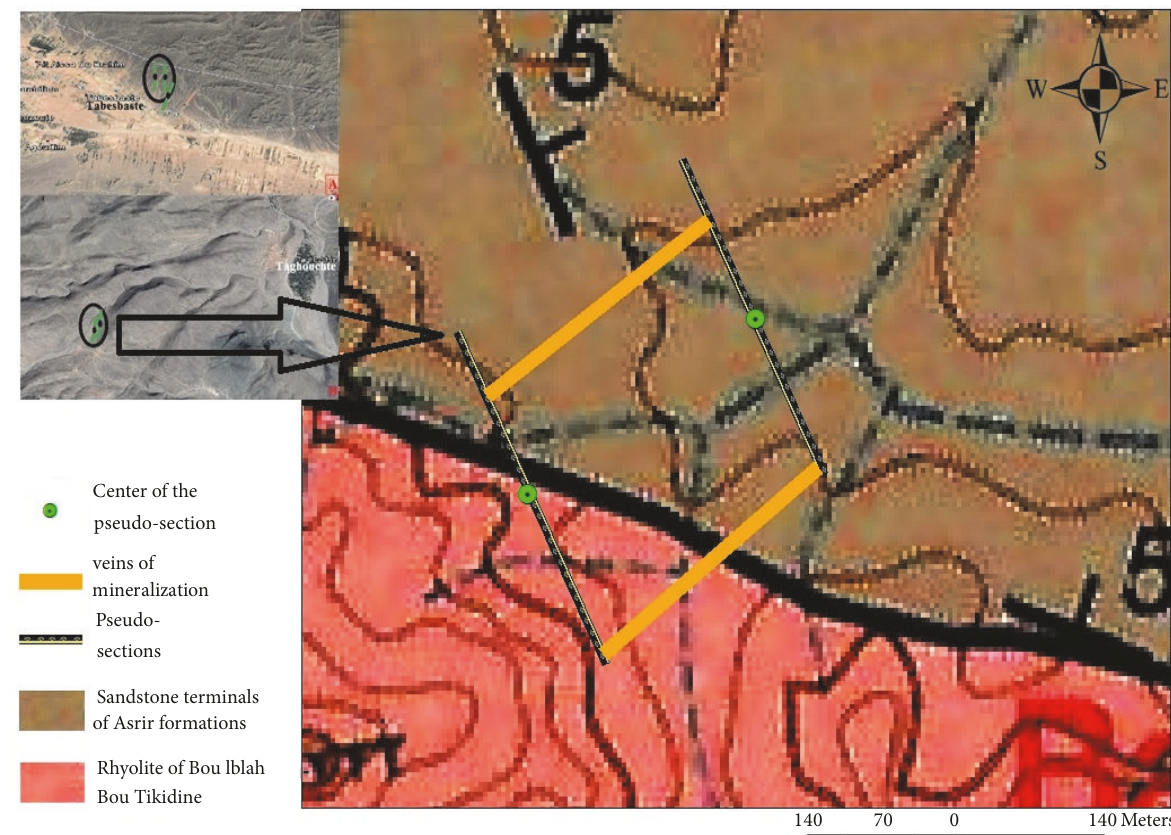
Figure 10: Map of correlation of the barite veins obtained by pseudosections 1 and 2(extracted from the Morocco Taroucht geological map